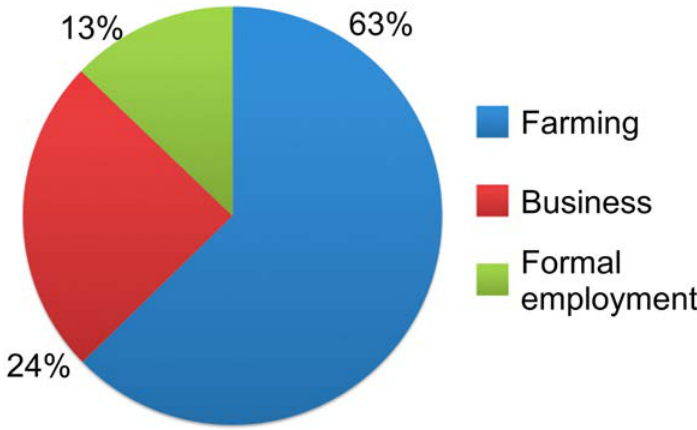
Figure 8. Economic activities of the local communities as of 2015, identified during questionnaire survey ( n = 327).